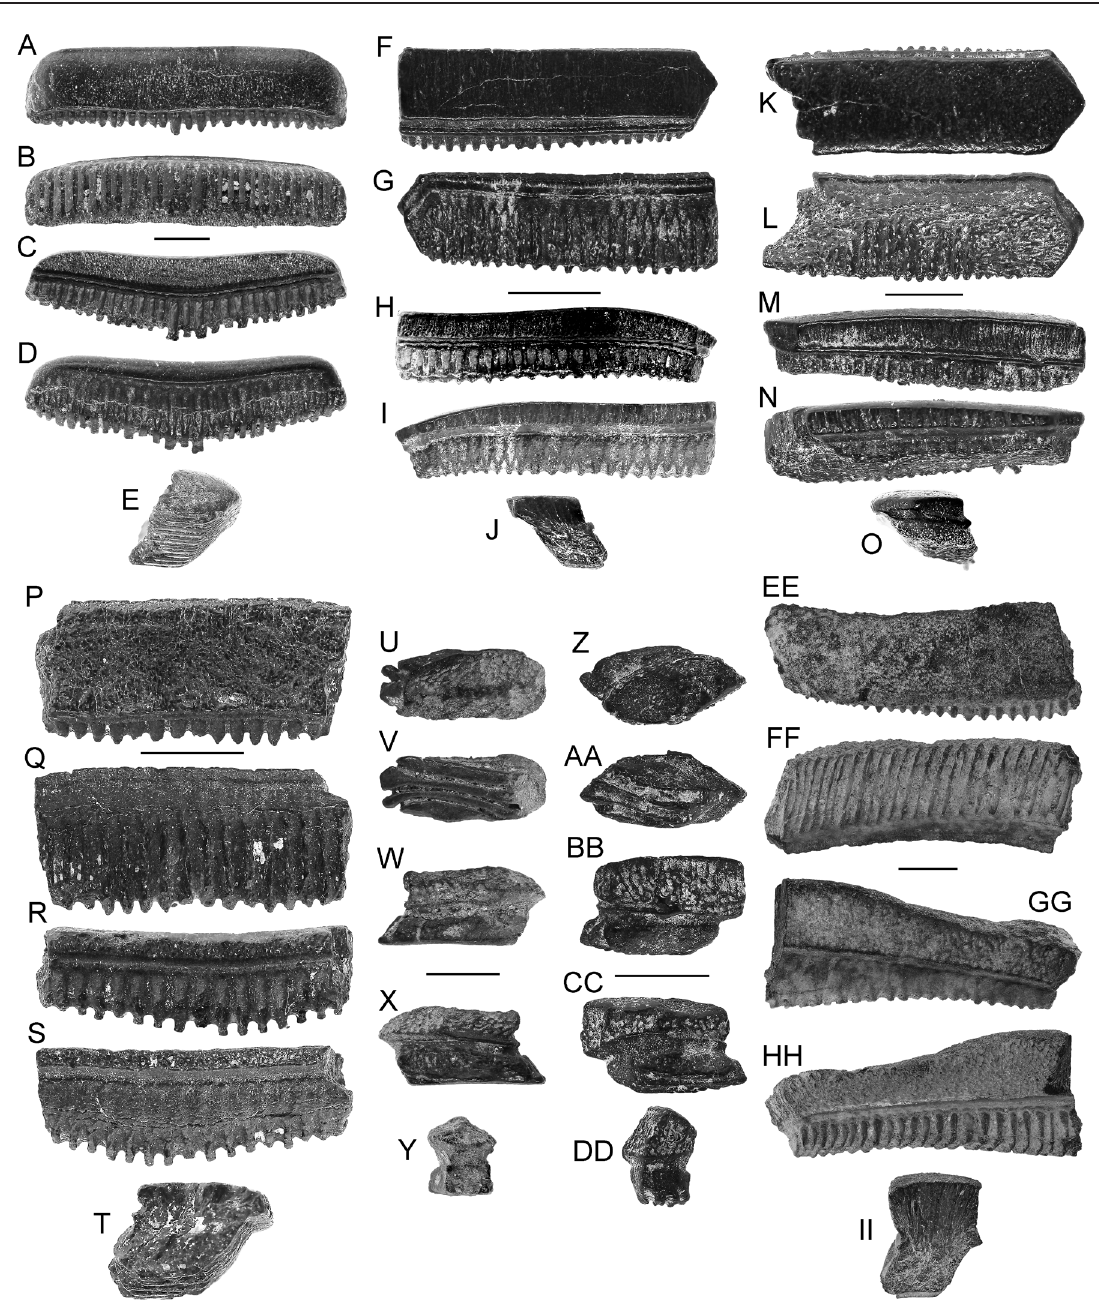
Fig. 46. Aetomylaeus sp., teeth. A–E . MSC 38836, lower median tooth, “upper” Lisbon